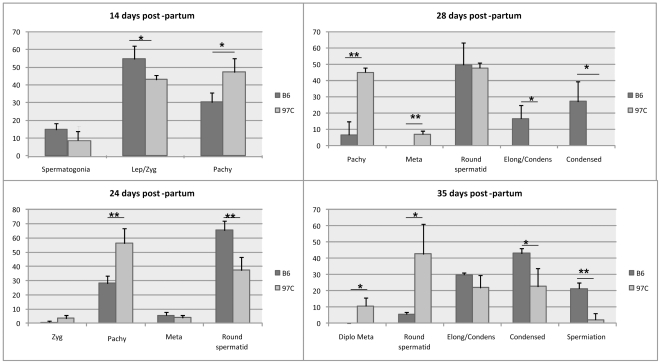
Distribution of the different stages of the spermatogenesis during the establishment of the first wave from 14 days post partum to 35 days post partum in testes of B6 (black bars) and 97 C (grey bars) mice.The results represent mean ± SD of the frequency of each stages observed in the testes of 3 or 4 males for each strain (with 50 to 130 tubule sections observed by male at each age). Abbreviation: Lep = leptotene; Zyg = zygotene; Pachy = pachytene; Diplo = diplotene; Meta = metaphase; Round spermatid corresponds to the steps 1 to 7 of the spermiogenesis; Elong/condens = elongating and condensing spermatid of steps 8 to 12 of the spermiogenesis; Condensed = condensed spermatid of steps 13 to16 of spermiogenesis. Different between B6 and 97 C at:* p<0.05; ** p<0.01; *** p<0.001 with student t test.